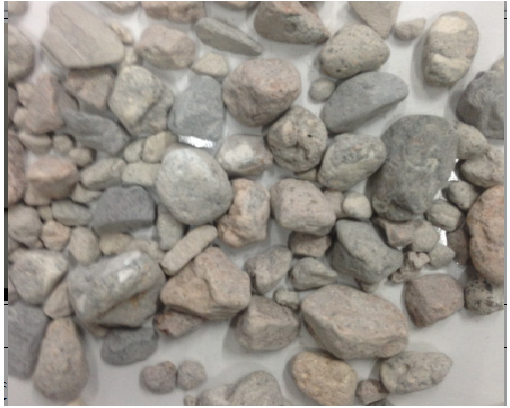
Figure 6. Aggregate morphology after ball milling.